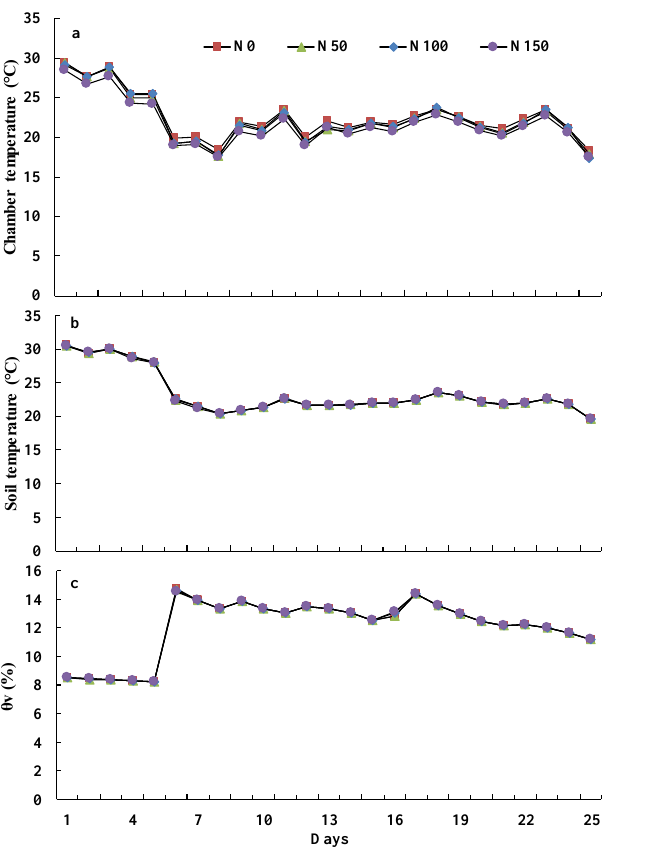
Figure 2. Average chamber temperature ( a ), 0 – 100 mm soil temperatures ( b ) and soil volumetric water content θ v ( c ) from four nitrogen addition treatments.